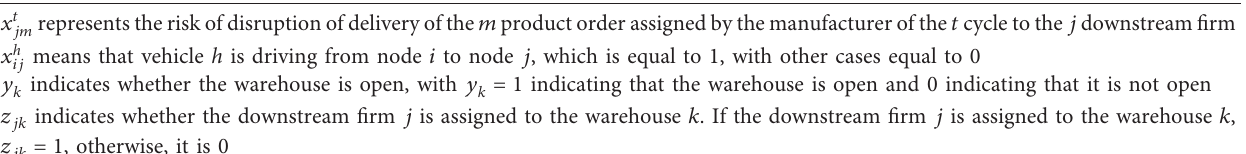
Table 3: Decision variables description of discrete supply networks.